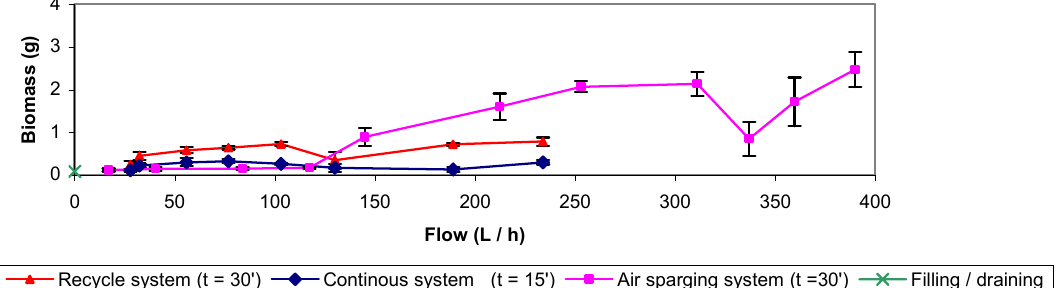
Figure 1. Backwashing (recycle and continous system), air sparging and filling / draining with distilled water at room temperature.